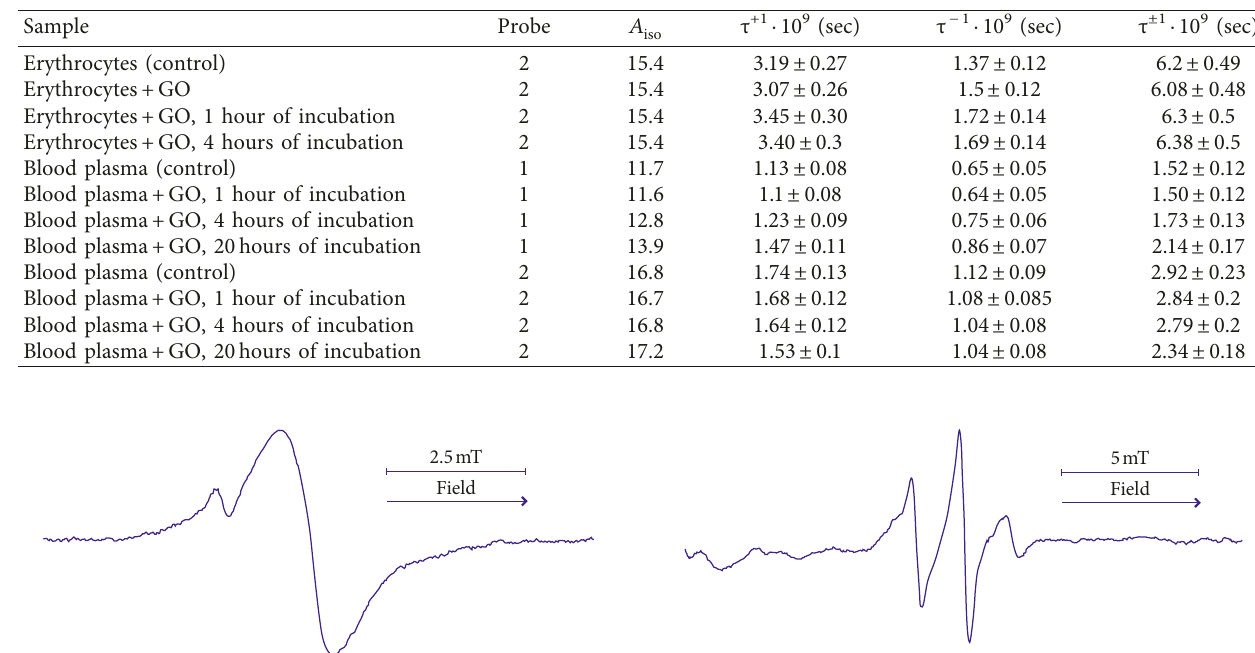
Table 1: Parameters of ESR spectra (probe correlation time ( τ ) and isotropic splitting constant ( A erythrocyte membranes and blood plasma.